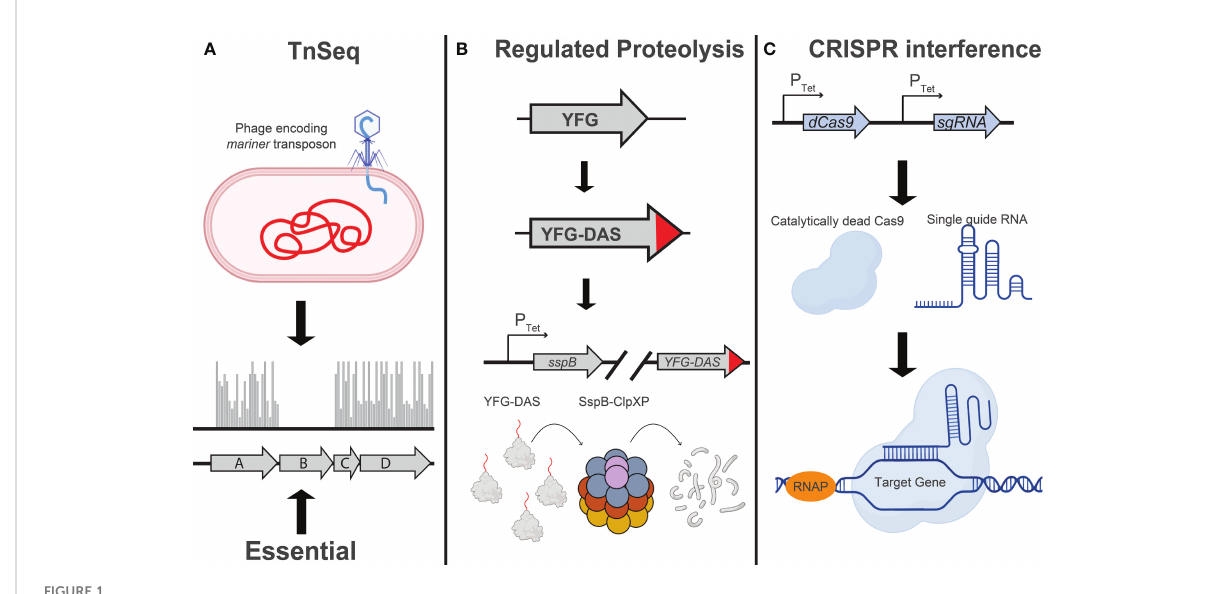
FIGURE 1 Techniques for large-scale genetic studies in Mtb: Illustration depicting the principles of (A) TnSeq, (B) regulated proteolysis, and (C) CRISPR interference as implemented in mycobacteria. (A) Transposon sequencing (TnSeq) involves transduction of Mtb with a phage encoding a mariner transposon, which will randomly insert at TA dinucleotides in the Mtb genome (Sassetti et al., 2001; Dejesus et al., 2017). The absence of transposon insertion events, as determined by next generation sequencing, indicates the essentiality of that gene under the conditions assayed. (B) Regulated proteolysis involves the addition of a C-terminal “ DAS ” tag to an endogenous Mtb gene (Kim et al., 2013; Johnson et al., 2019). Addition or removal of tetracycline, depending on the variant of TetR being used, will induce expression of the proteolytic adaptor, SspB, and facilitate ClpXP-mediated degradation of the DAS-tagged protein. The level of target knockdown can be modulated by using different Tet-regulated promoters to drive sspB expression. (C) CRISPR interference (CRISPRi) utilizes a single guide RNA (sgRNA) to localize a nuclease-dead Cas9 enzyme to a speci fi c target sequence in the Mtb genome, sterically blocking transcription initiation or elongation. Modulation of target knockdown level can be achieved by designing an sgRNA targeting a divergent protospacer adjacent motif (PAM) sequence, which is directly adjacent to the sgRNA target sequence (Rock et al., 2017), or modulating the extent of complementarity between the sgRNA and the DNA target (Qi et al., 2013; Vigouroux et al., 2018; Hawkins et al., 2020; Bosch et al., 2021; Mathis et al., 2021). Figure graphics were generated using Biorender